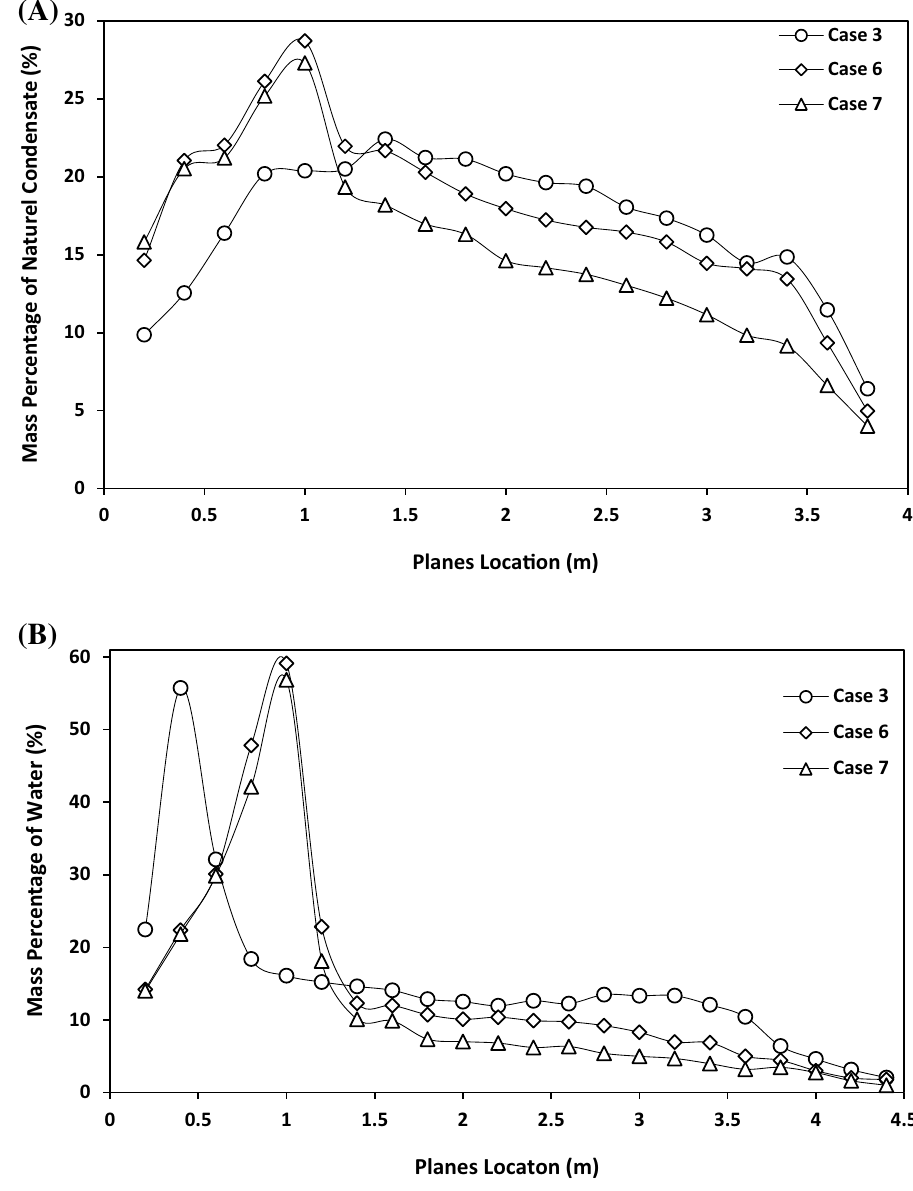
Fig. 22 Simulated mass dis- tribution of condensate in the water zone ( a ) and water in the condensate zone ( b ) of Cases 3, 6 and